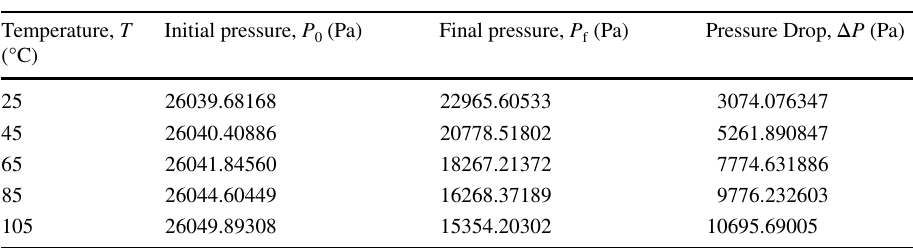
Table 4 Effect of temperature